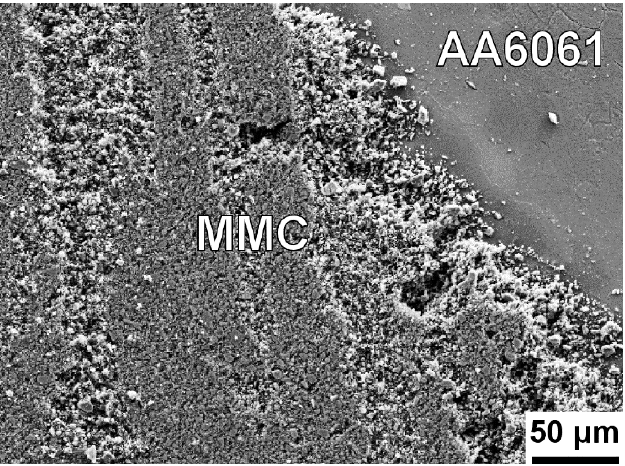
Figure 4. Secondary electron image from the central region of the joint (region B in Figure 3b) showing the interface between the MMC and the AA6061 alloy in the friction stir welded plate.